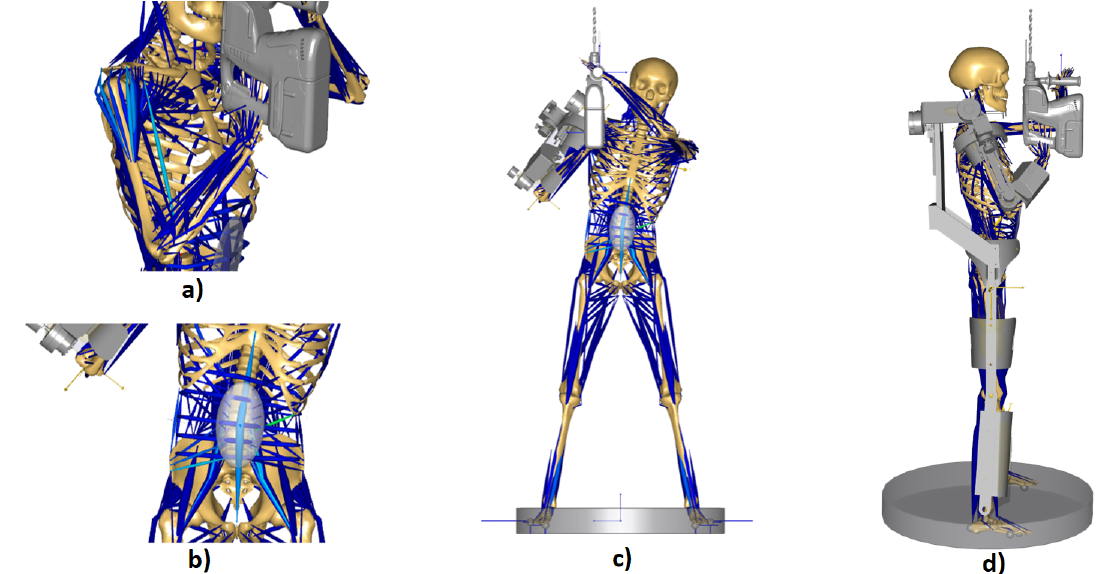
Figure 6. ( a ) Detail of the most loaded muscles in the simulation without the exoskeleton. ( b ) Detail of the most loaded muscles in the simulation with the upper-limb exoskeleton. ( c ) Simulation with the upper-limb exoskeleton. ( d ) Simulation with the full